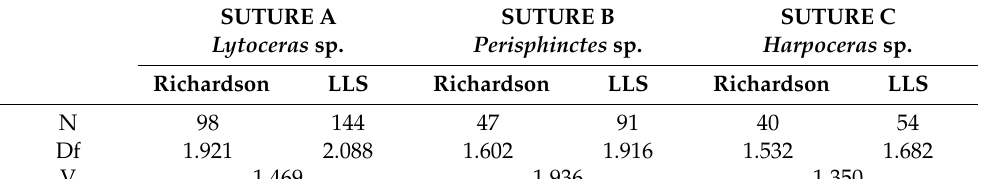
Table 1. Comparison of results for calculating the fractal dimension of three different am- monite suture lines from File S1 (in the Supplementary Materials for this manuscript) using the Richardson and LLS step Methods. Step length = 1/15 appropriate base line distance in each case. N = number of steps; Df = fractal dimension of suture line; V = conversion value needed to make the LLS Df = Richardson Df . Suture A is from a shell of the genus Lytoceras , Suture B is from a shell of the genus Perisphinctes, and Suture C is from a shell of the genus Harpoceras . SUTURE A Lytoceras sp.